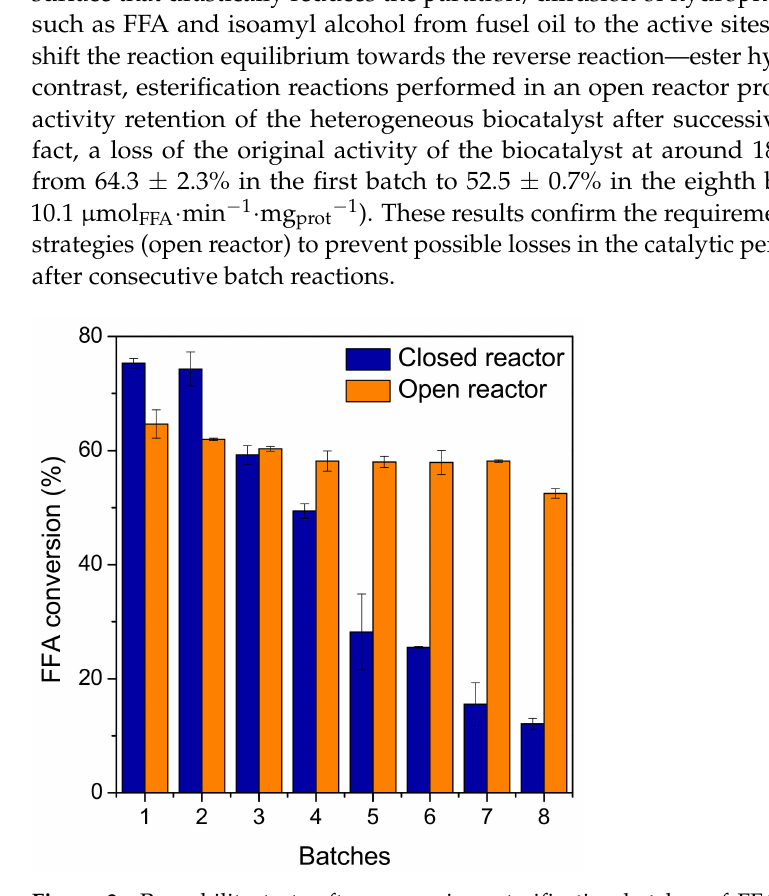
Figure 3. Reusability tests after successive esterification batches of FFA from USCO and fusel oil conducted in closed and open reactor catalyzed by immobilized ET2.0 on PSty-DVB beads. The reactions were at 40 ◦ C, 240 rpm, stoichiometric FFA:fusel oil molar ratio (1:1), and protein concentration of 5 mg.g − 1 of reaction